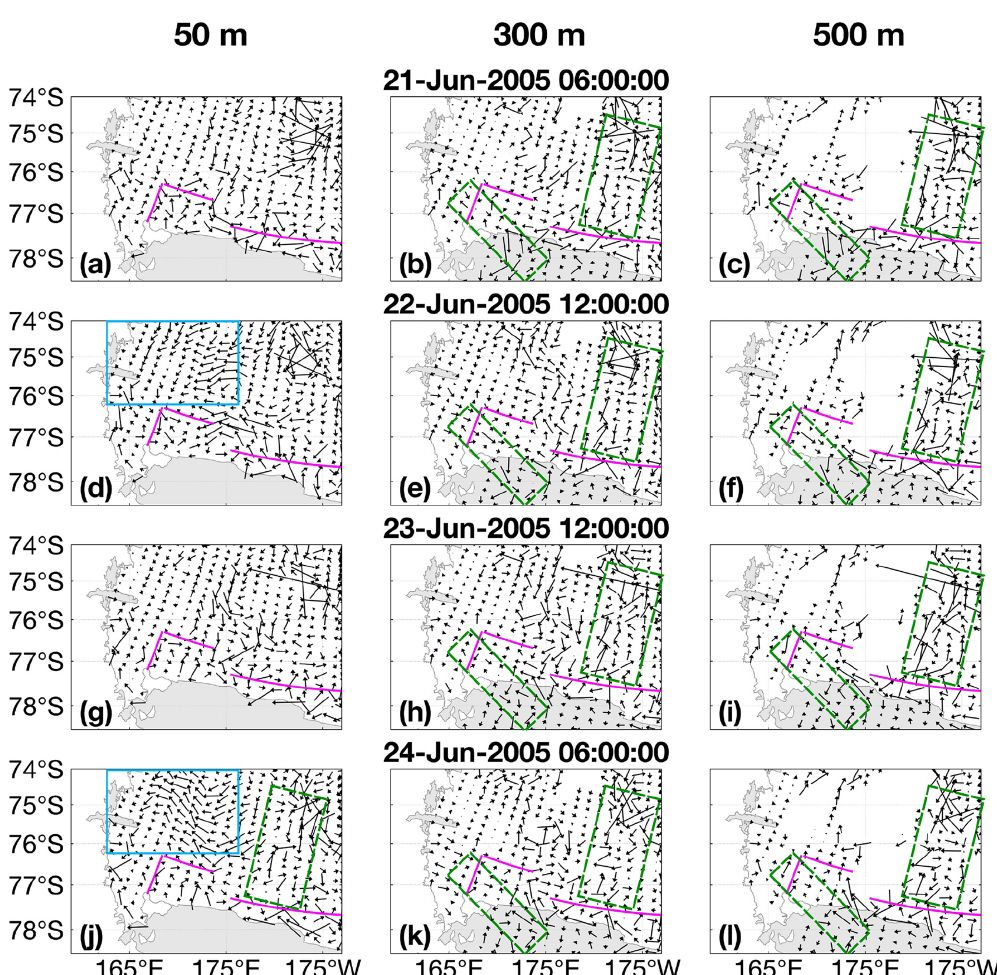
Figure 15. Spatial distributions of ocean currents at the depth of (a, d, g, j) 50m, (b, e, h, k) 300m, and (c, f, i, l) 500m at four selected time points (06:00 on 21 June, 12:00 on 22 June, 12:00 on 23 June, and 06:00 on 24 June). The magenta lines are the S1, S2, and S3 sections defined in Fig. 1b. The blue boxes indicate the areas where westward Ekman transport is observed. The green boxes near S1 and S3 indicate the areas where southeastward and outward (northward) flows are present